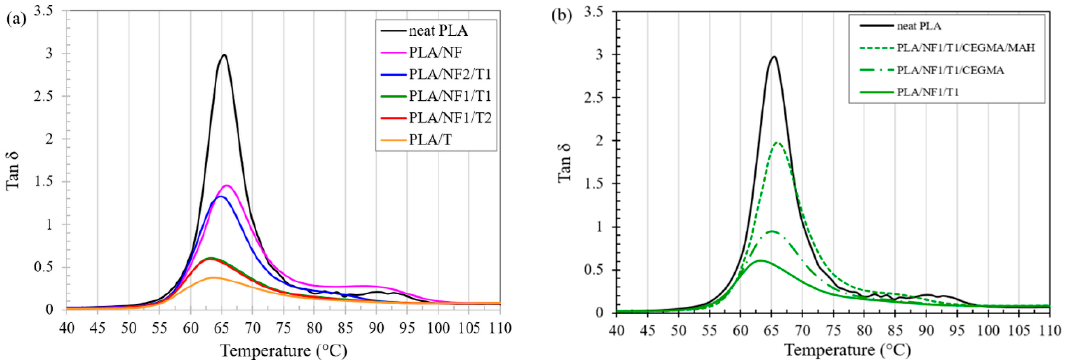
Figure 5. Plot of tan δ against temperature of PLA hybrid composites at: ( a ) different fillers ratios; ( b ) with and without various reactive compatibilizers.